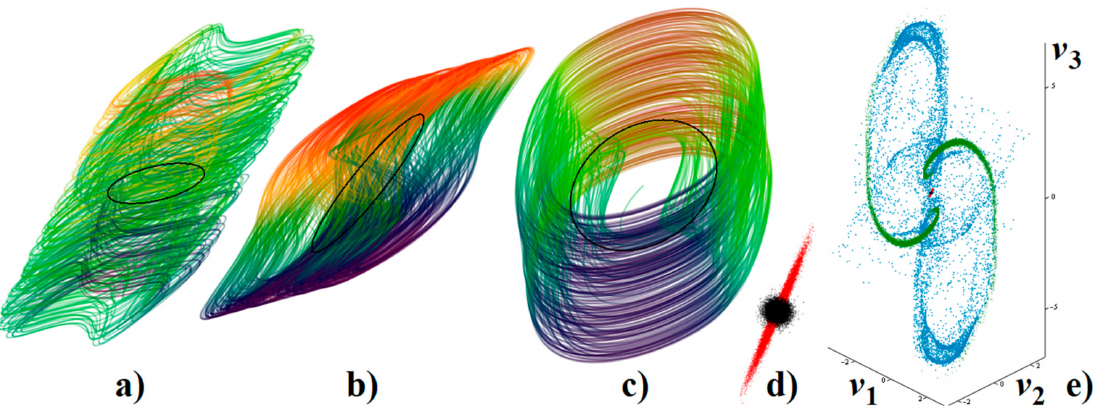
Figure 2. Typical strange attractor generated by transistor-based Clapp oscillator visualized in differ-